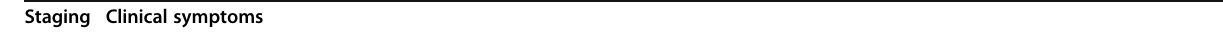
Table 2 Staging and treatment strategies for MRONJ Staging Clinical symptoms Stage 0 systemic management, including use of pain medications and antibiotics improvement of oral hygiene (rinsing and cleaning of fistulas and periodontal pockets) Stage 1 antibacterial mouth rinse clinical follow-up on a quarterly basis improvement of oral hygiene (rinsing and cleaning of fistulas and periodontal pockets) patient education and review of indications for continued bisphosphonate therapy Stage 2 combination or monotherapy of symptomatic treatment with oral antibiotics and/or oral antibacterial mouth rinse pain control debridement to relieve soft tissue irritation and infection control